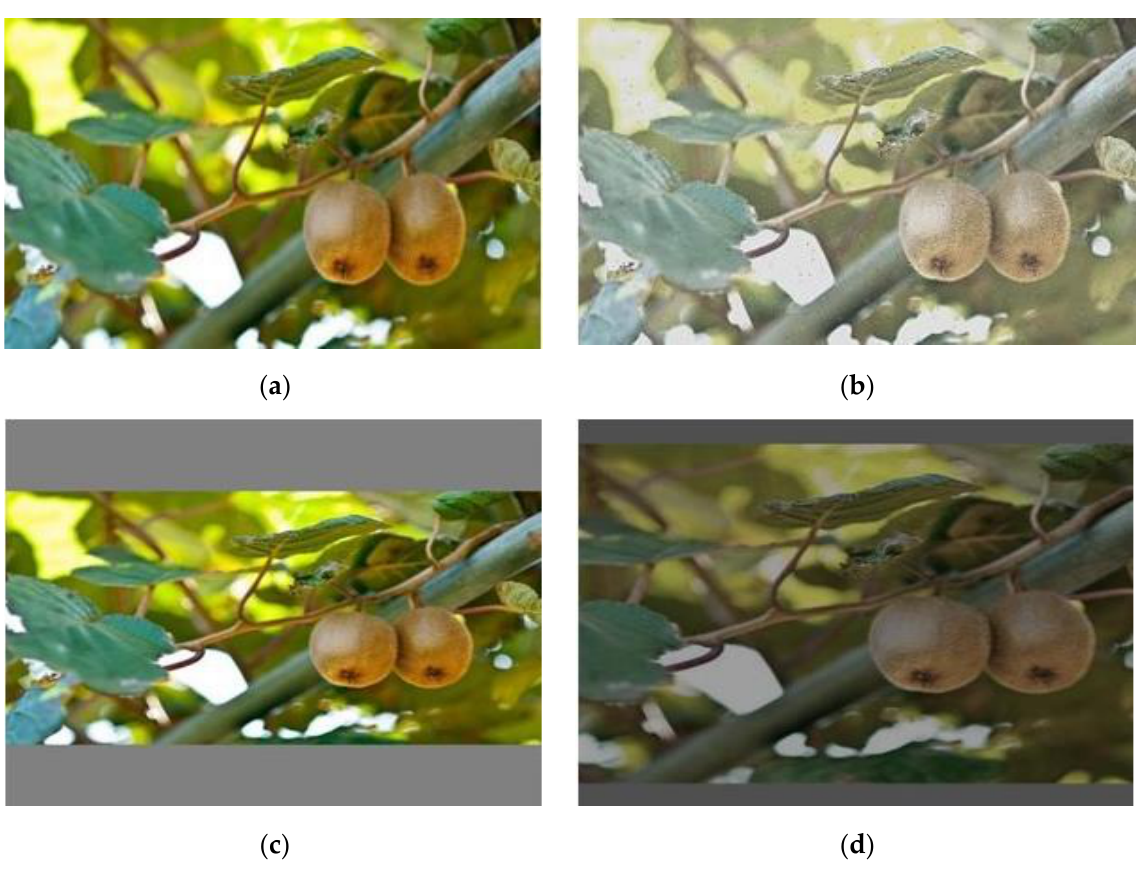
Figure 2. Manipulations of the kiwi image dataset. ( a ) Original image; ( b ) Applying salt and pepper noise; ( c ) Padding; ( d ) HSV (Hue, Saturation, Value) transforming. noise; ( c ) Padding; ( d ) HSV (Hue, Saturation, Value)